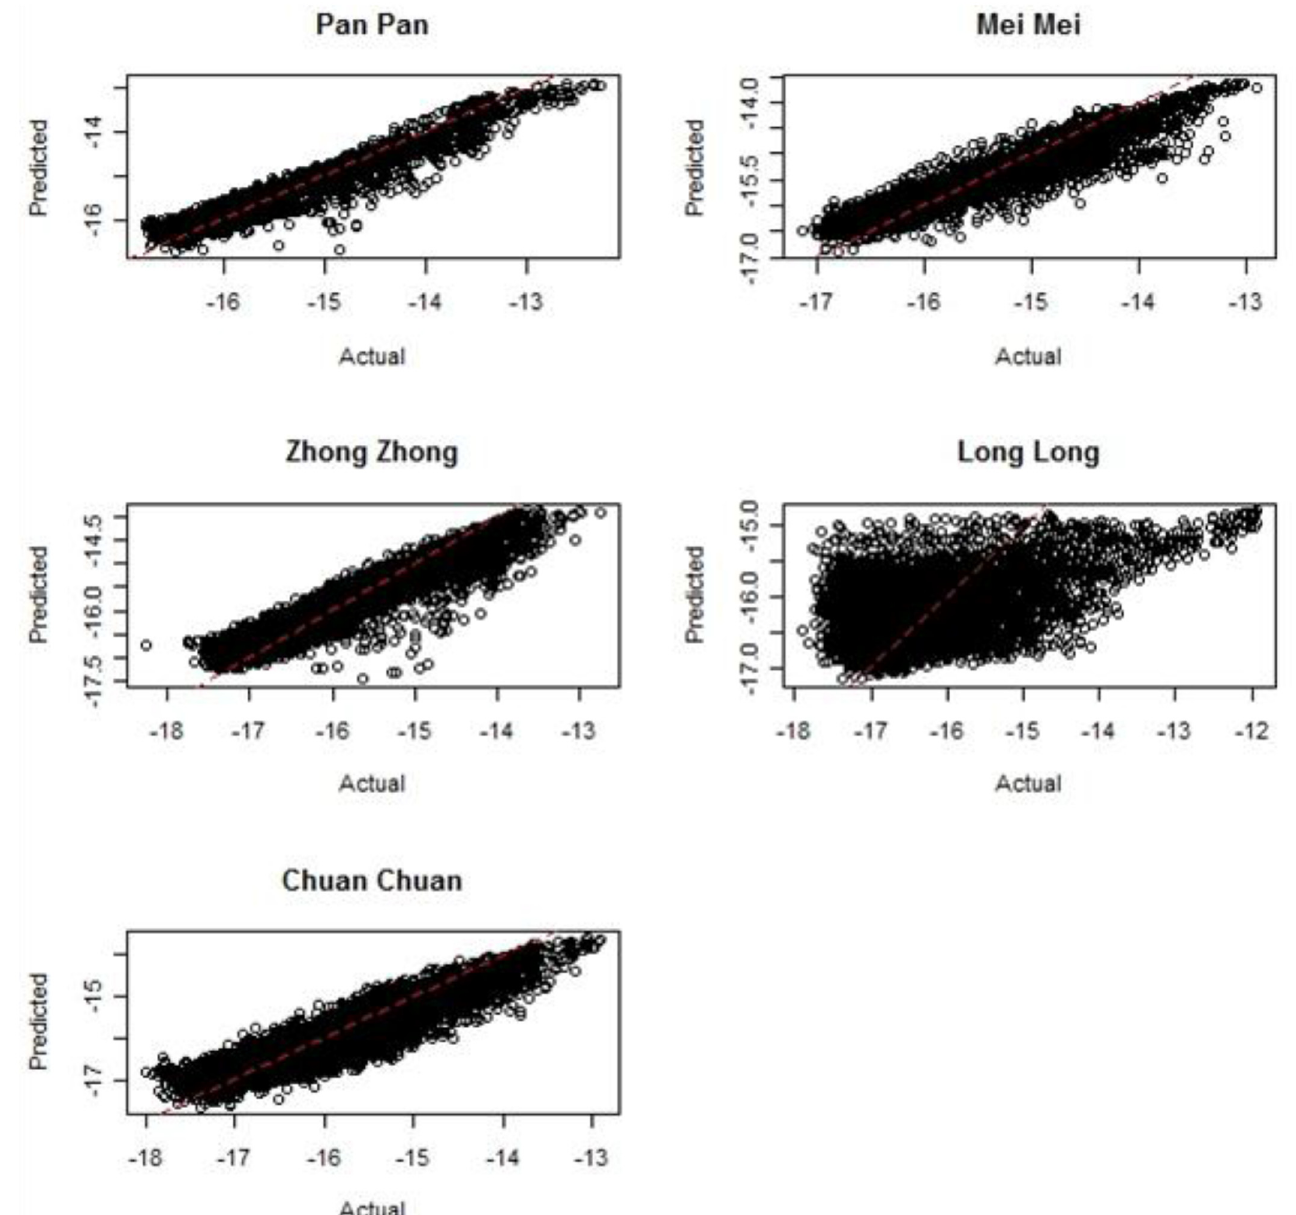
Fig 5. Fit of simultaneous autoregressive (SAR) models depicted by actual versus predicted log-transformed response variables (utilization distributions) for each panda.